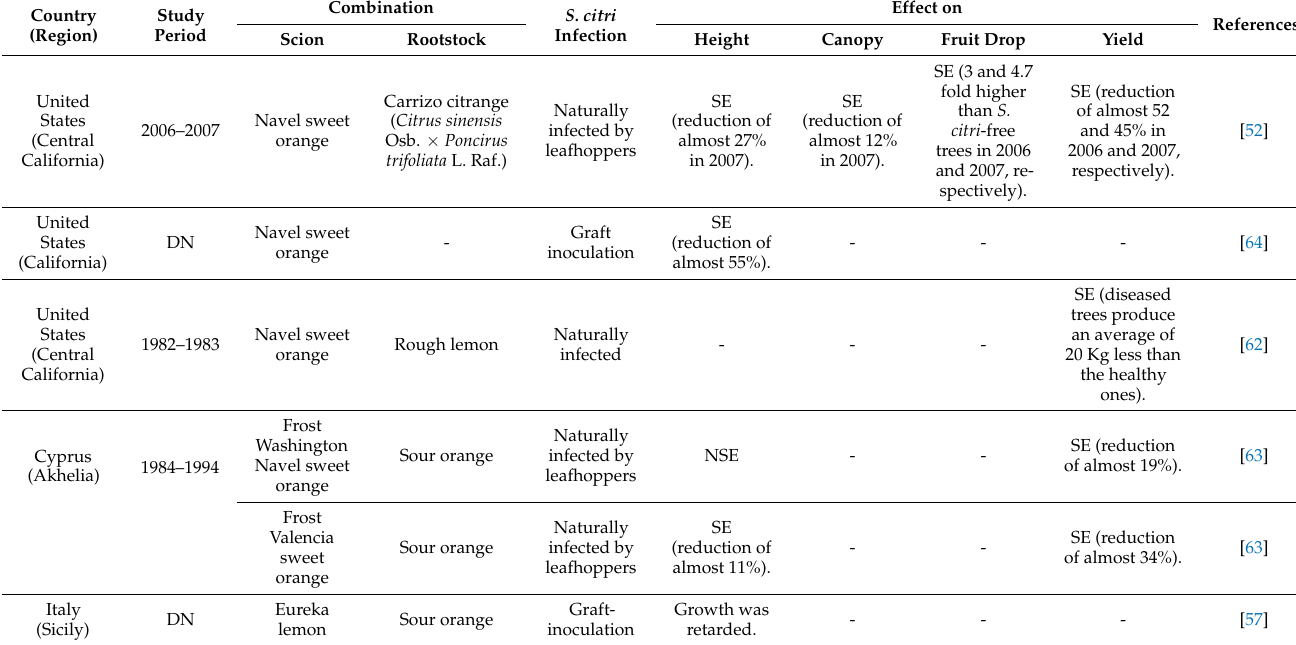
Table 1. Results summary of the known field trials carried out in different citrus-growing countries to evaluate the effect of Spiroplasma citri on vegetative growth and yield of different citrus scion and rootstock